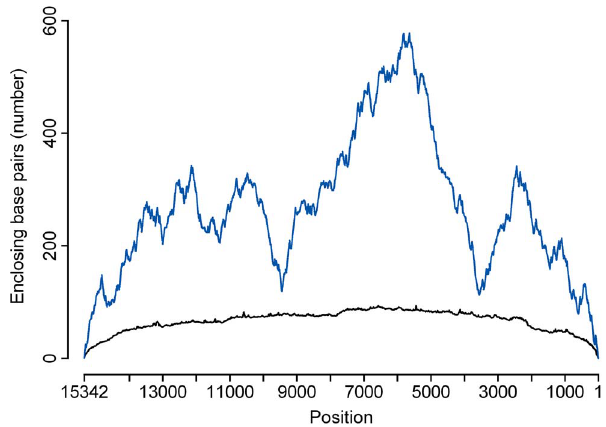
Figure 2. Mountain plot representation of viral RNA secondary structure. Based on base pair probabilities of genomic position. The Y- axis represents the number of base pairs enclosing the base at a certain position in the predicted RNA secondary structure (direct measure of secondary structure complexity). The X-axis represents the position on the APMV-8 genome. The equilibrium pair probabilities were predicted (Figure 3 B; Spearman rank correlation coefficient of repetition